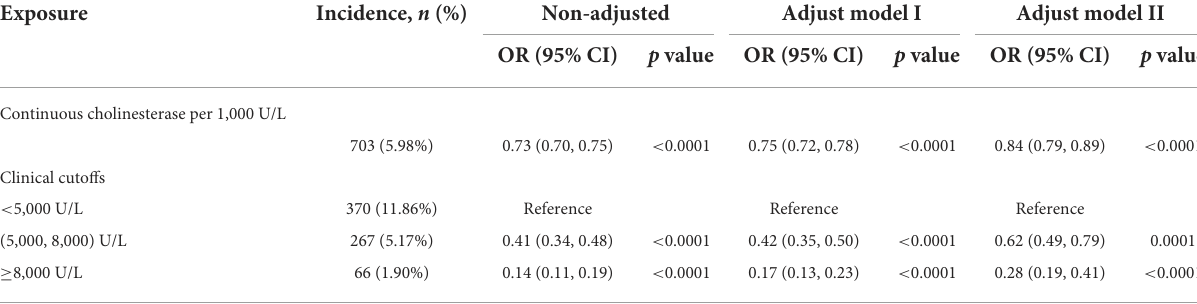
TABLE 4 Individual effect of serum cholinesterase on all-cause